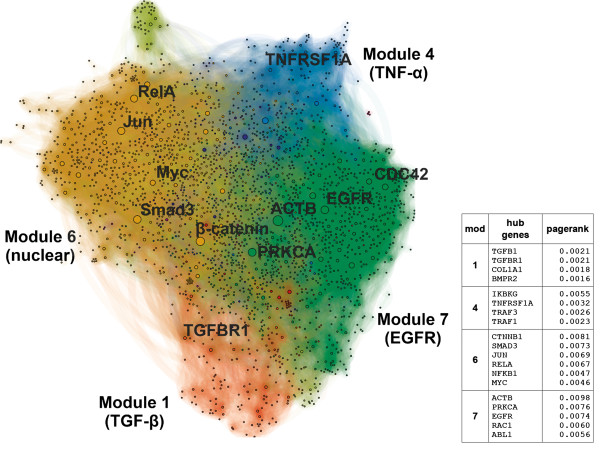
The translational readout of the epithelial-mesenchymal transition-related gene clusters (EMT-GCs) forms a modular protein-protein interaction network of EMT signaling (EMT-network). The EMT-network is based on experimentally determined interactions and induced by genes from the EMT-GCs. Nodes are genes from the EMT-GCs and additional genes that directly mediate their interactions. Node sizes are proportional to PageRank scores. Genes with high scores are network hubs. The EMT-network is partitioned into eight modules, four of them labeled and color-coded. The predominant functional characteristic of each module is indicated. The side table lists genes with the highest PageRanks in each of the four core modules.